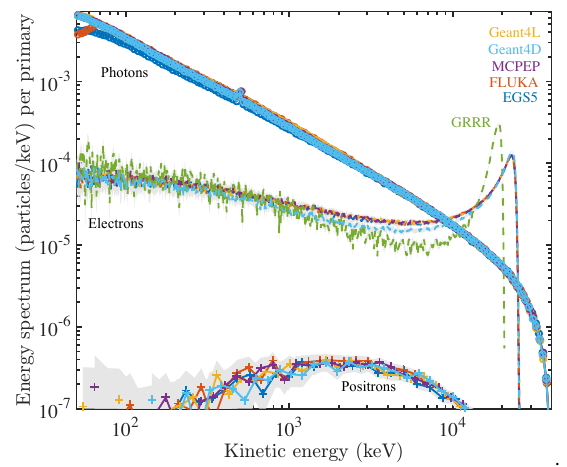
Figure 3. The same as in Fig. 2, but now for 40MeV electrons. The propagation distance of 0.5 times their CSDA range is now 63.8m (1bar and 273K). Now, not only electrons and photons but also positrons have been produced. The difference in electron distribu- tion is due to straggling by bremsstrahlung; see Sect. 5.1